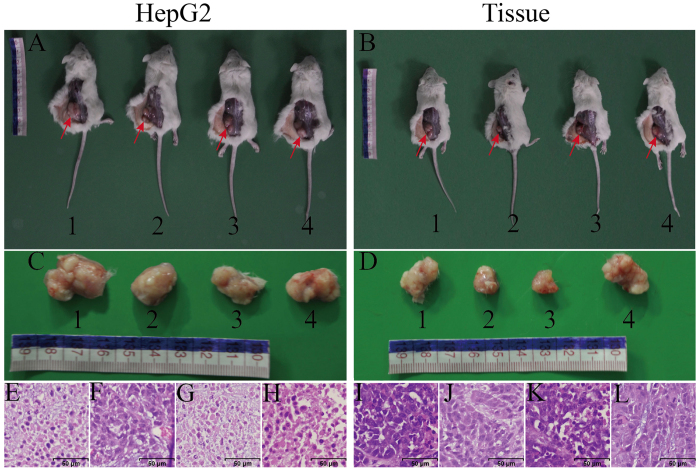
In vivo tumorigenicity of SP cells.Mice injected with SP cells (5 × 102/mouse) (A1–3) and unsorted cells (1 × 106/mouse) (A4) from HepG2 cells and tumors completely detached from the mice (C) were presented. The corresponding histological micrographs were shown in (E–H). Representative picture of mice injected with SP cells (5 × 102/mouse) (B1–3) and unsorted cells (1 × 106/mouse) (B4) from 18 HCC patient tissues and tumors completely detached from the mice (D) were presented. The corresponding histological micrographs were shown in (I–L).